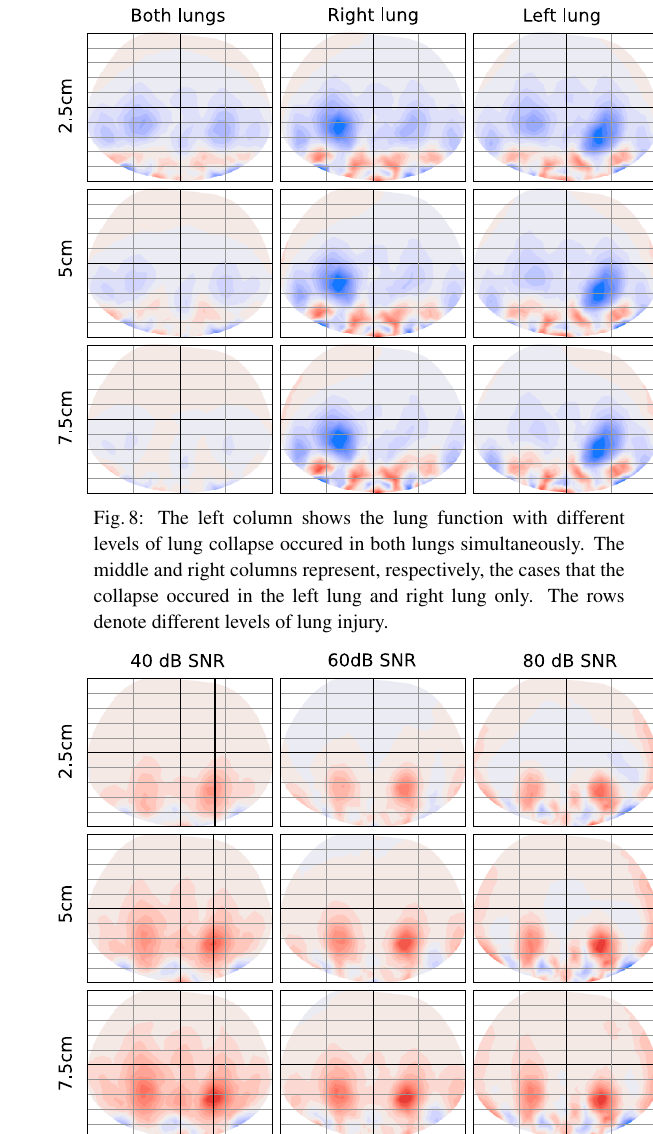
Fig.9: Image reconstructions of the edematous region for different levels of collapse. The rows denote different levels of lung